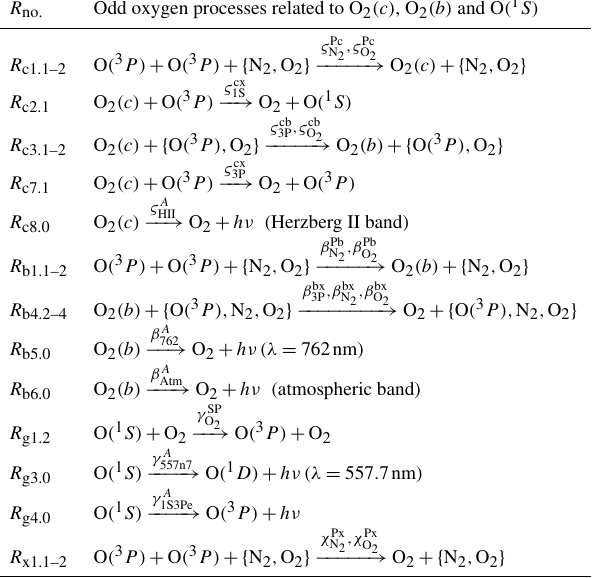
Table 4. Processes of the extended O ( 1 S) nightglow model (Hickey et al., 1997; Huang and George, 2014) hereafter referred to as the H model; see Sect. 3.2.2. The MAC model includes all processes listed here and also the processes shown in Tables 6 and